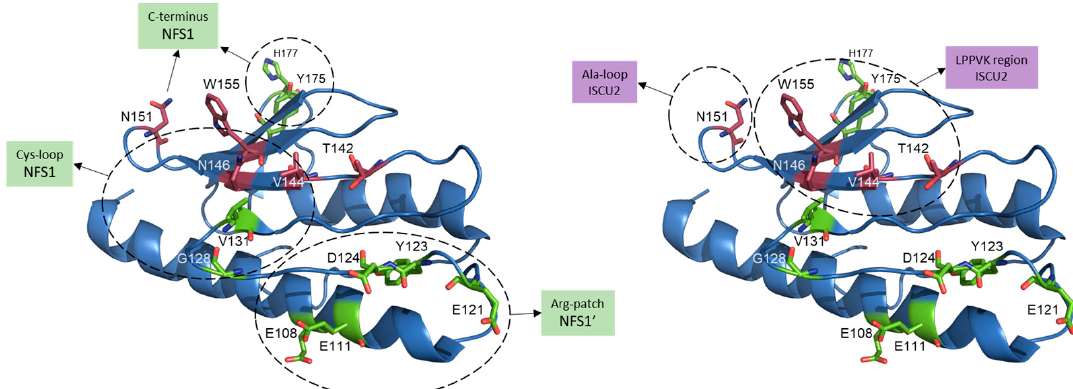
Figure 5. Residues involved in FXN binding to the mitochondrial Fe–S core complex. Human FXN structure from SDUAF Cryo–EM structure (6NZU, [21]) with some of the key residues involved in the interaction with ISCU2 (in magenta) and with both NFS1 subunits (NFS1 and NFS1 ′ , in green). Dashed circles indicate residues interacting with different regions of NFS1 or NFS1’ ( left ), or with different regions of ISCU2 ( right ). N151, N146 and V144 residues are likely involved in the interaction with both ISCU and NFS1.